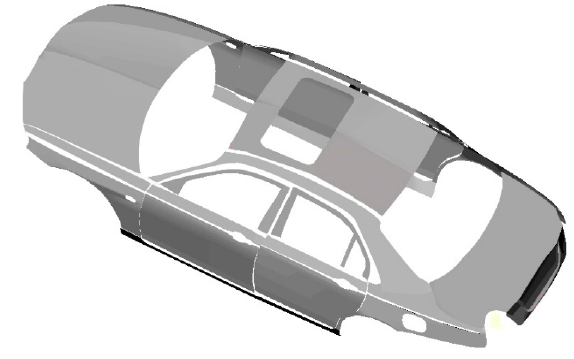
Figure 11. Car body shape after pre-processing of point cloud data.